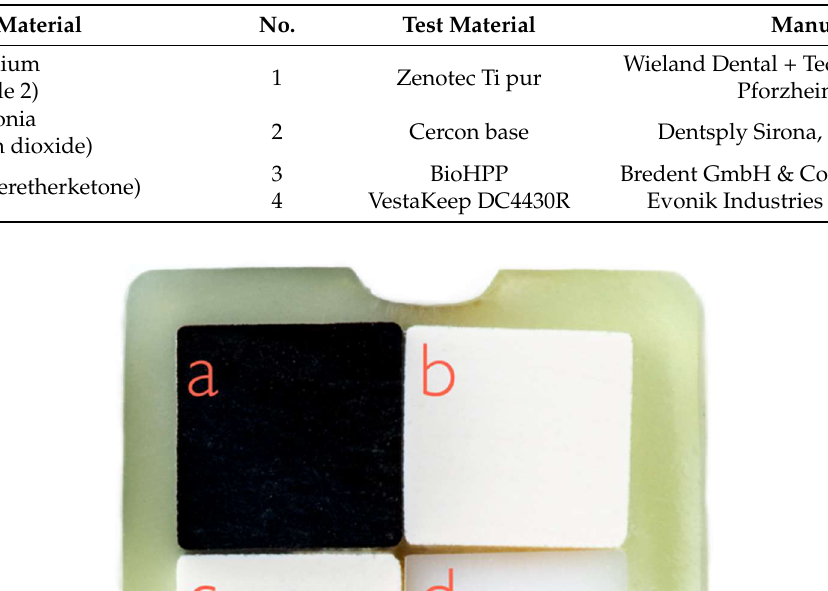
Table 3. Test implant abutment materials used in this study.